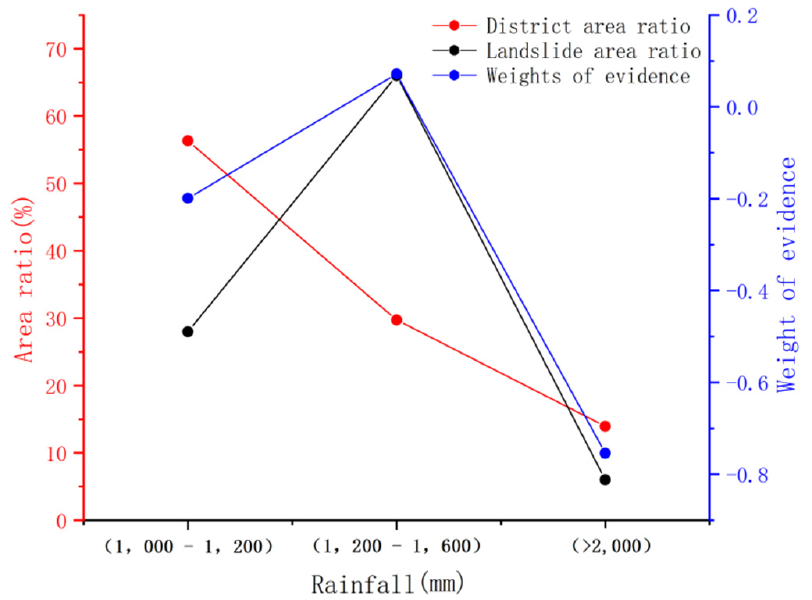
Figure 9. Rainfall statistical analysis results.